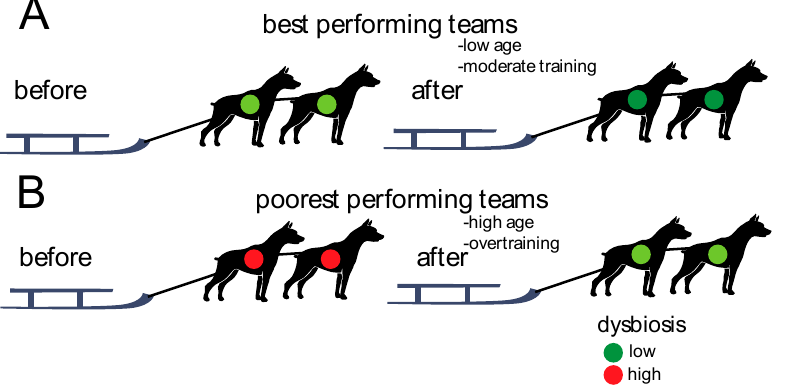
Figure 5. Schematic association between performances and dysbiosis. ( A ) The best performing teams showed the lowest degree of dysbiosis initially (before the race) and the lowest changes after the race. ( B ) The poorest performing teams showed the highest degree of dysbiosis initially (before the race) and the largest changes after the race.